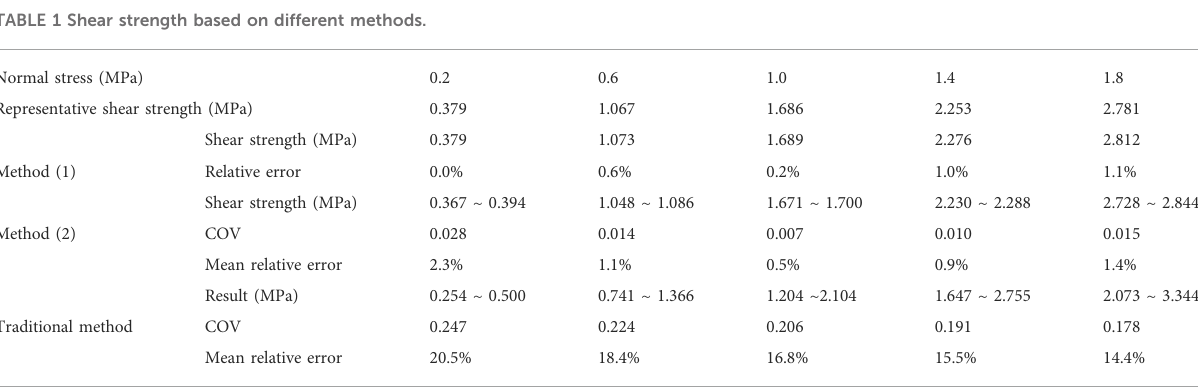
TABLE 1 Shear strength based on different